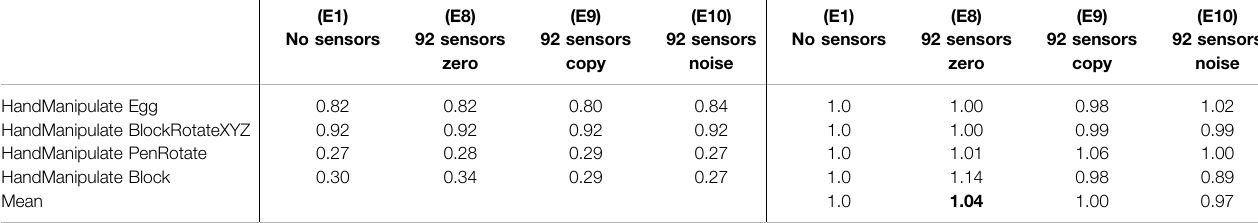
TABLE 6 | Experiments E8 – E10 ( Figure 6 ): Success Rate Convergence Levels (columns 2 – 5) and Success Rate Convergence Level Ratio (columns 6 – 9).